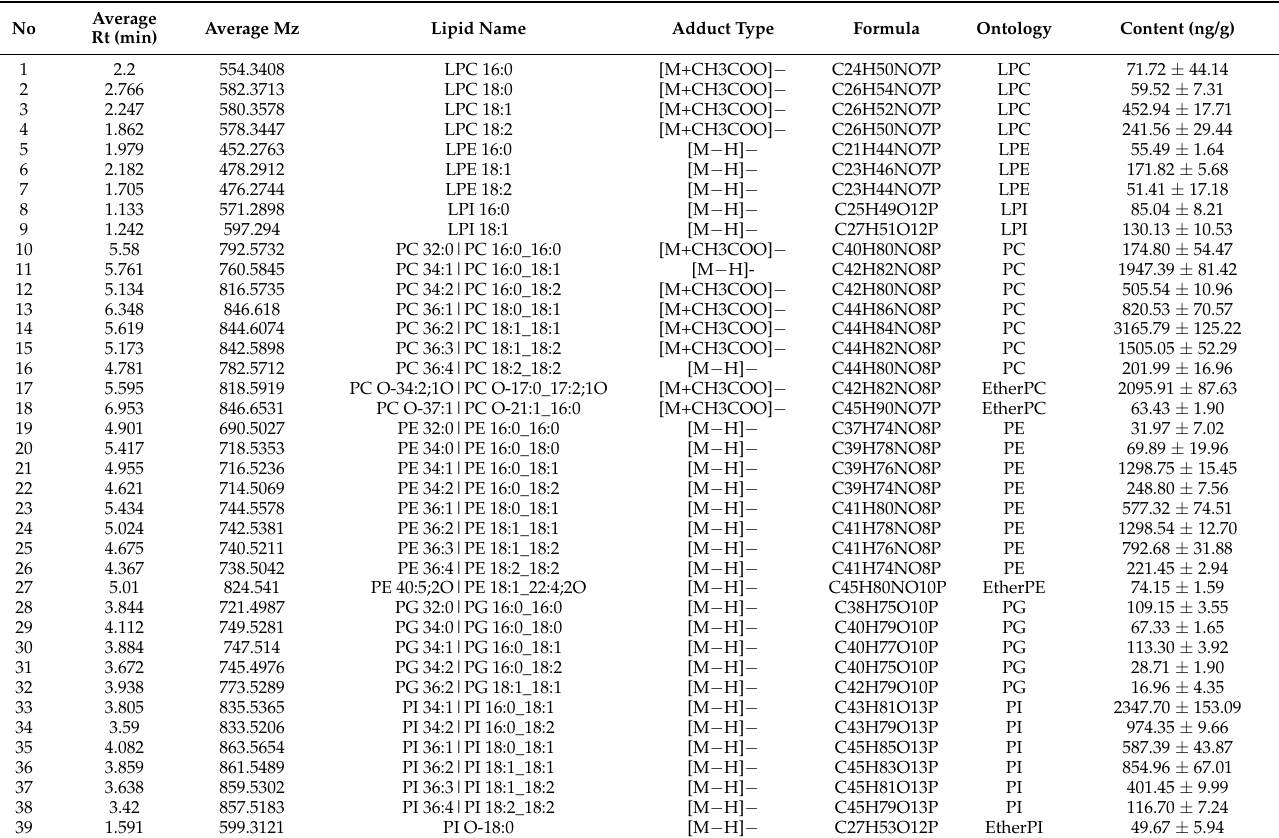
Table 2. Composition of the 39 phospholipids in cashew nut kernel